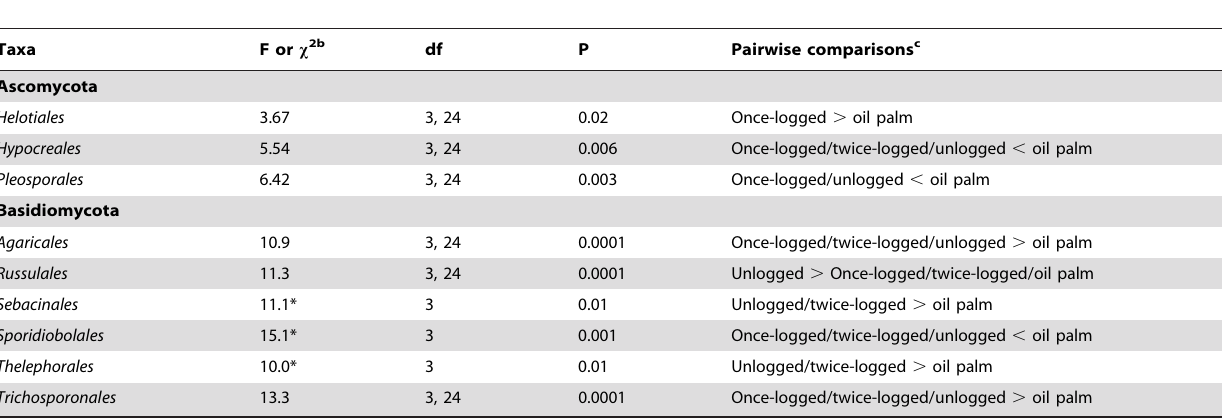
Table 1. Comparison of relative abundance of the dominant fungal orders within the phyla Ascomycota and Basidiomycota among land uses a